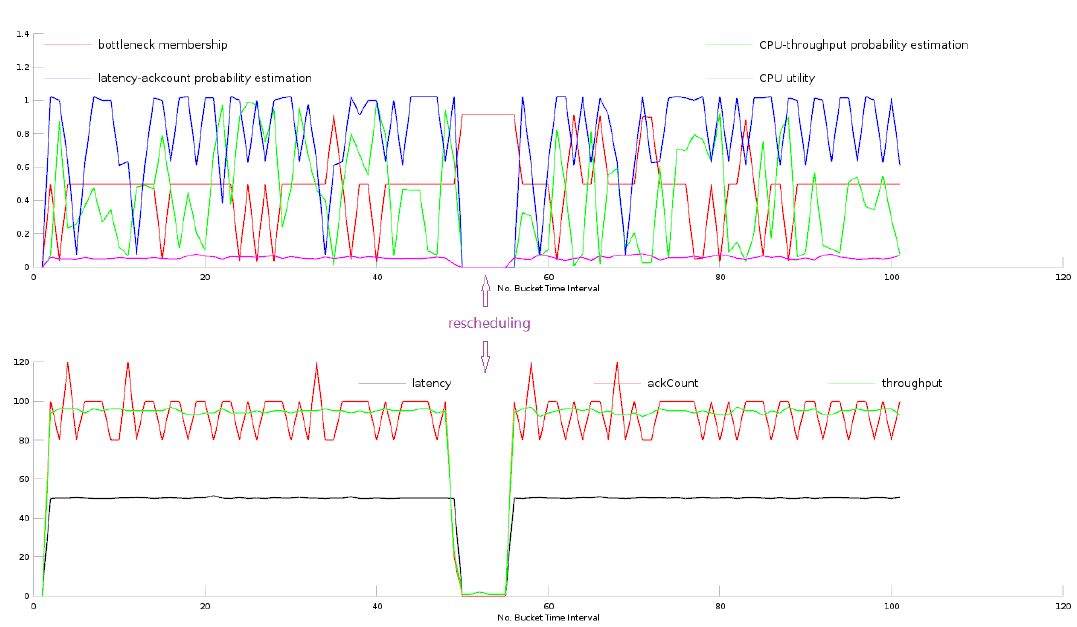
Figure 7. Metric patterns when rescheduling a